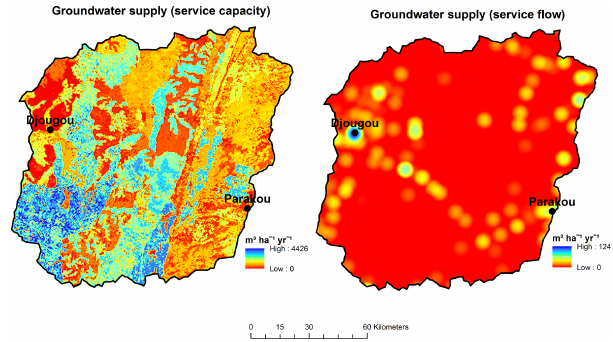
Figure 7. Spatial distribution of mean annual values of service ca- pacity and service flow of water purification in the Upper Ouémé watershed from 2001 to